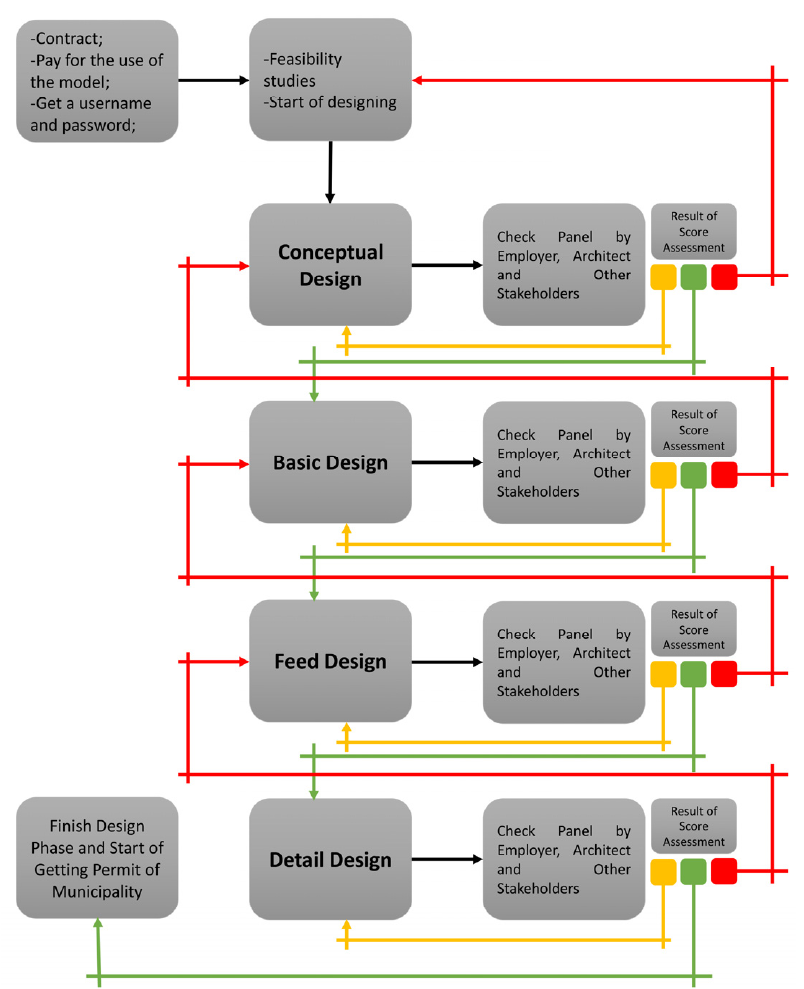
Figure 3. The BIM-based quality management model for the design phase.